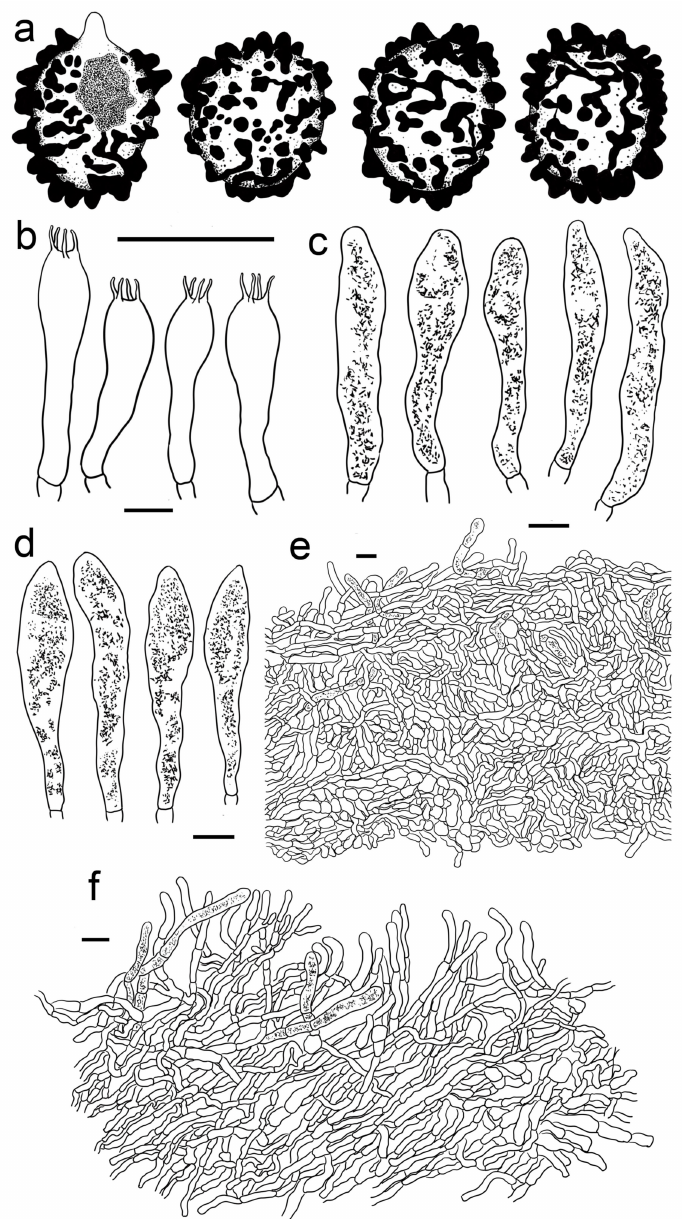
Figure 7. Russula gracillima (HBAU15527). ( a ) Basidiospores. ( b ) Basidia. ( c ) Cheilocystidia. ( d ) Pleu- rocystidia. ( e ) Suprapellis and partial subpellis in pileus centre. ( f ) Suprapellis in pileus margin. Bars: ( a ) = 5 µ m, ( b – f ) = 10 µ